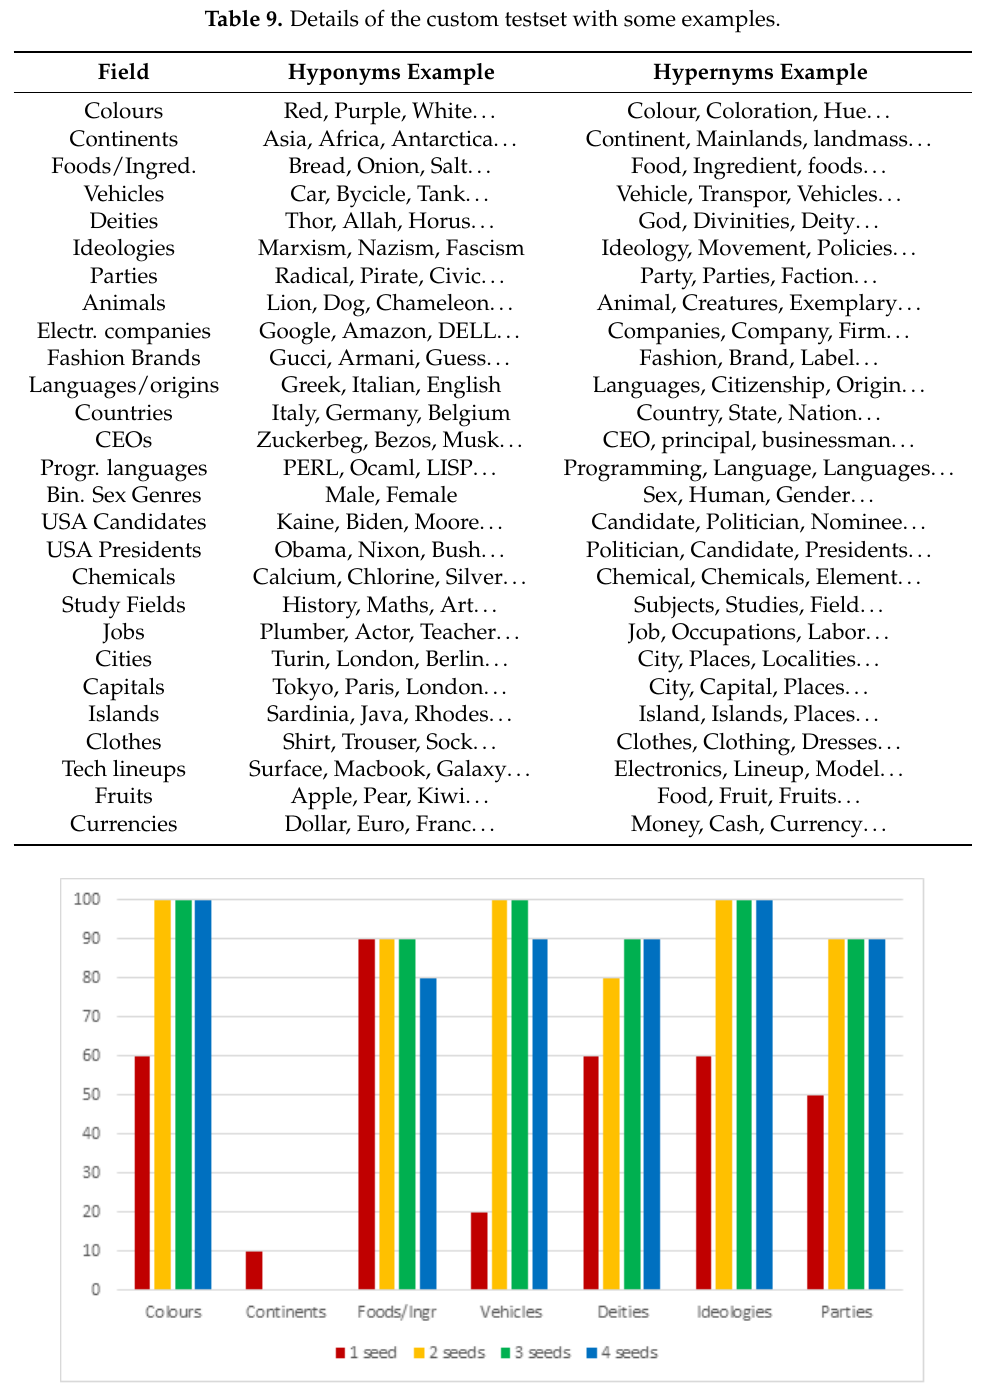
Figure 1. Results on our testset